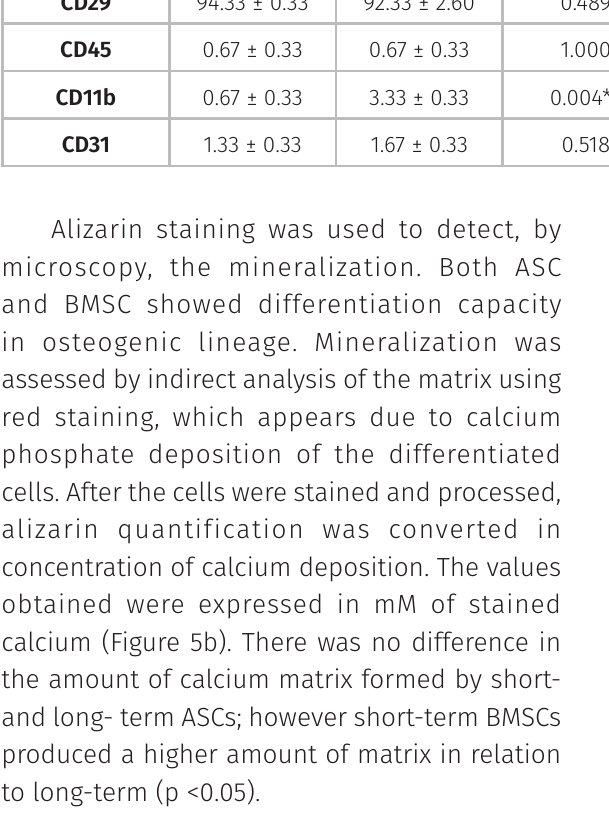
Table I. Comparison between expression percentage of surface markers at different passages and in each cell type. Short – Short-term culture and Long – Long-term culture. Data is presented as mean ± S.D.* p <0.05 and ** p<0.01 (n=3). ASC BMSC Markers Short (%) Long (%) p value Short (%) Long (%) p value CD90 89.33 ± 2.19 98.00 ± 0.58 0.019 * 82.67 ± 1.20 85.33 ± 1.45 0.230 CD44 98.67 ± 0.33 96.00 ± 0.58 0.016 * CD29 94.33 ± 0.33 CD45 CD11b 0.67 ±